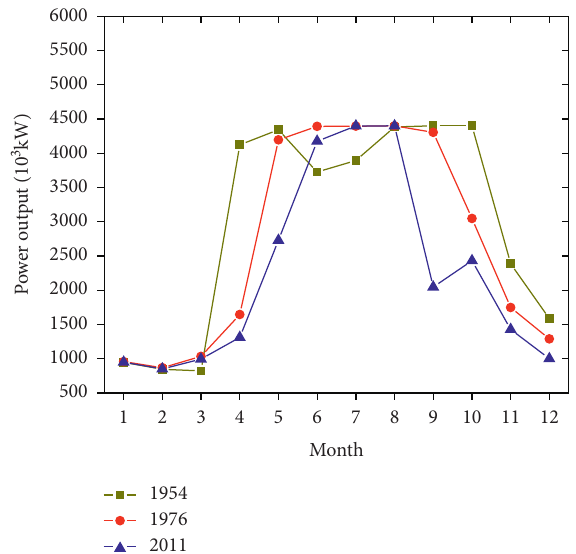
Figure 9: Power output results of the three typical